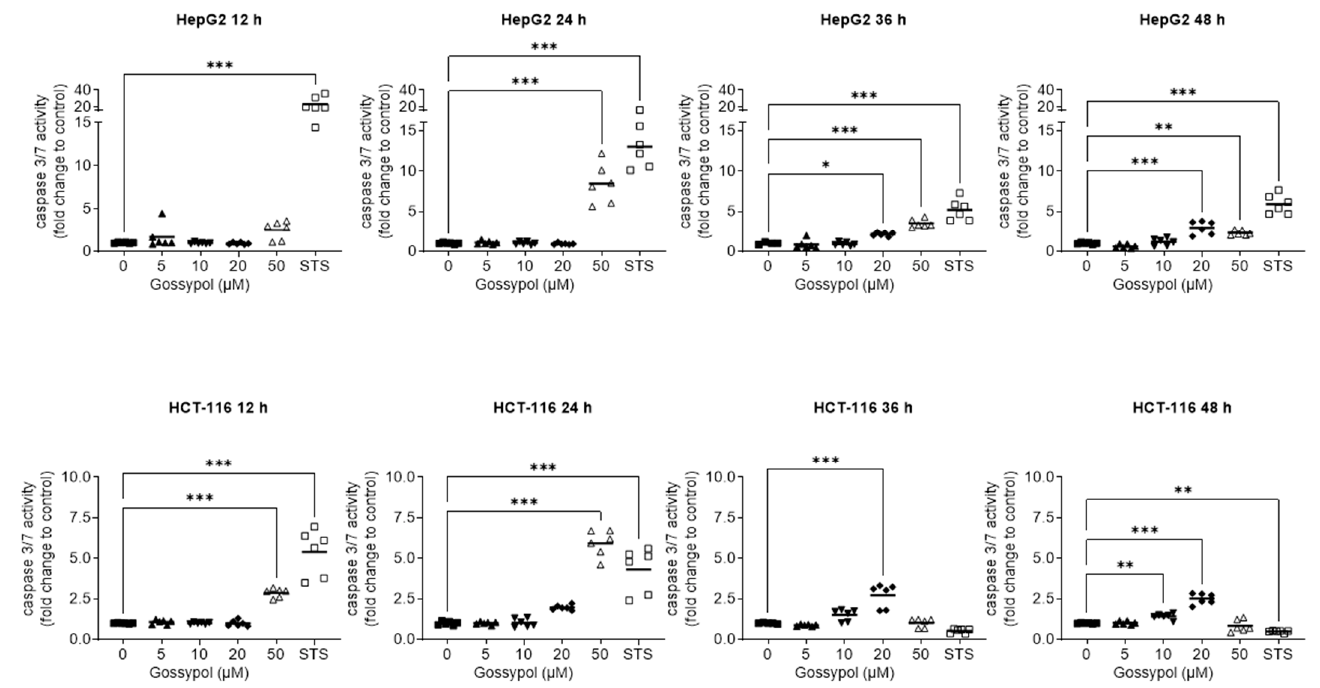
Figure 3. Gossypol activates caspases 3/7. Gossypol activates caspases in a